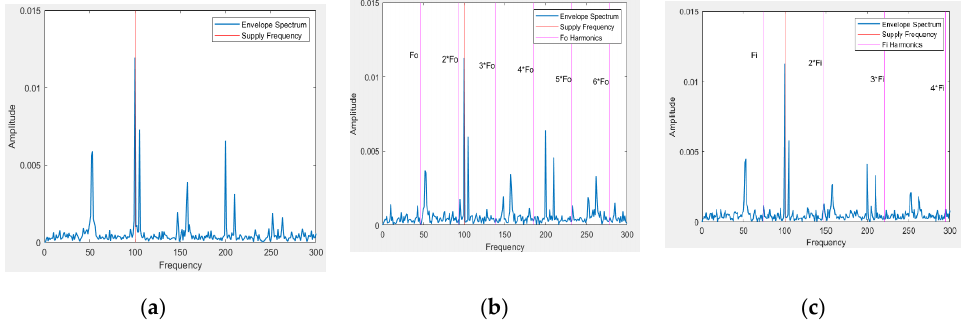
Figure 5. Envelope spectrum analysis of three conditions of current signals: ( a ) normal, ( b ) outer fault, and ( c ) inner fault .